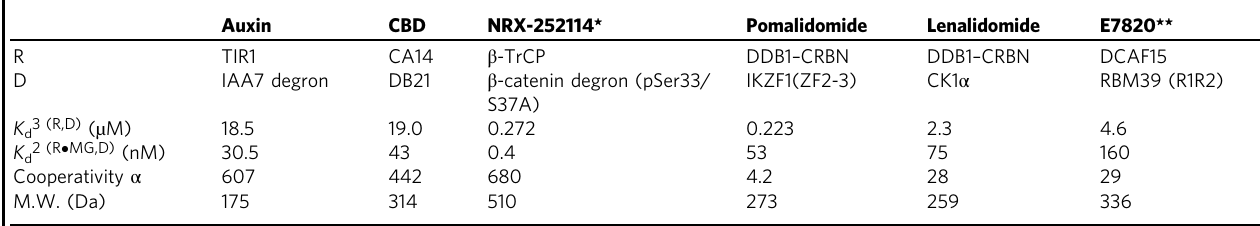
Table 1 Thermodynamic features of select molecular